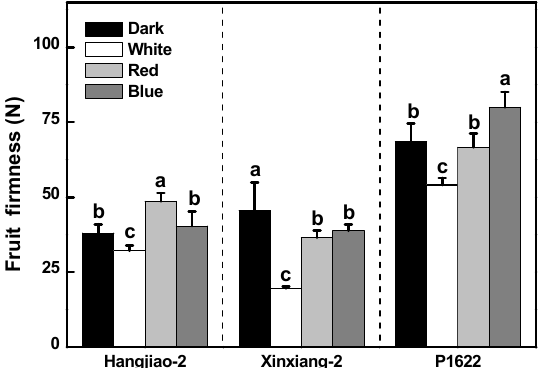
Figure 2. Effect of light quality on fruit firmness. Results are shown as mean ± SE of twelve samples. Means denoted by the same letter were not significantly different at p < 0.05 according to Tukey’s test.